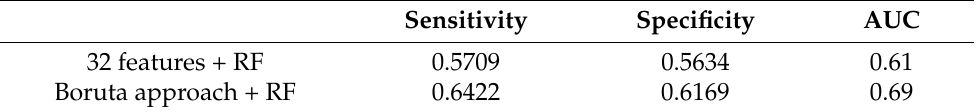
Table 12. Results for DR classification.